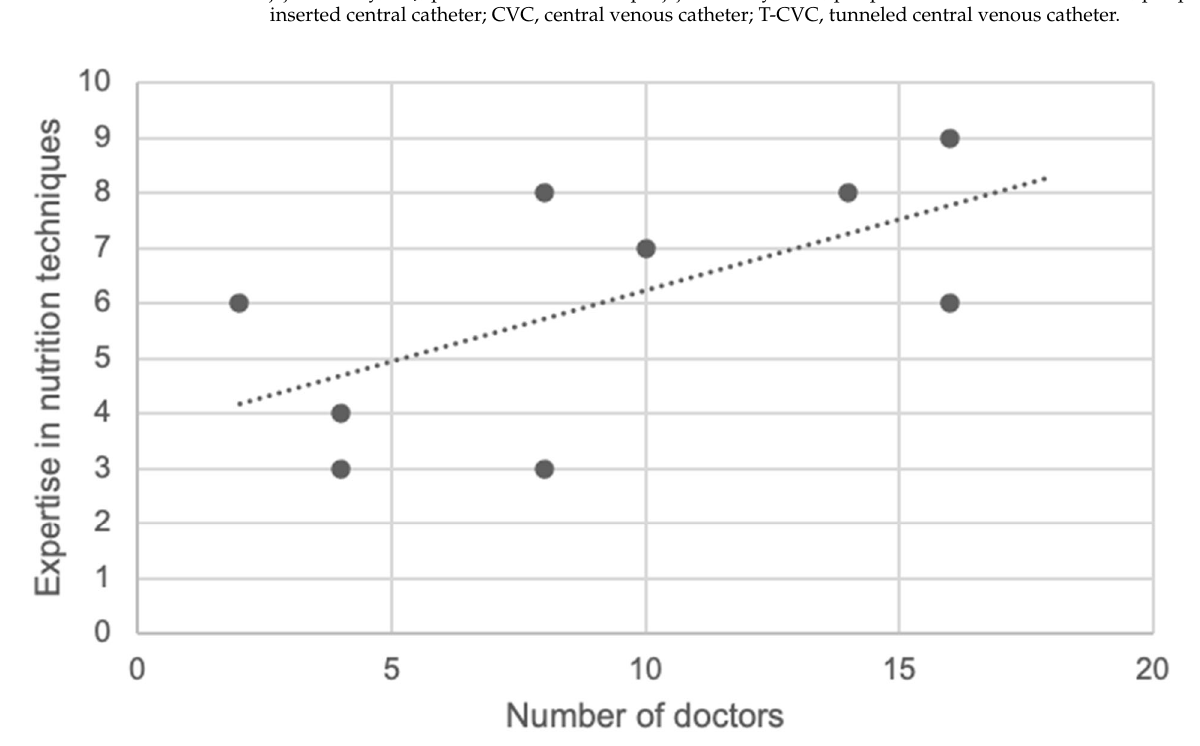
Figure 2. Linear correlation between number of doctors and expertise in nutrition techniques. Black dots refer to data from each involved center ( n = 9).